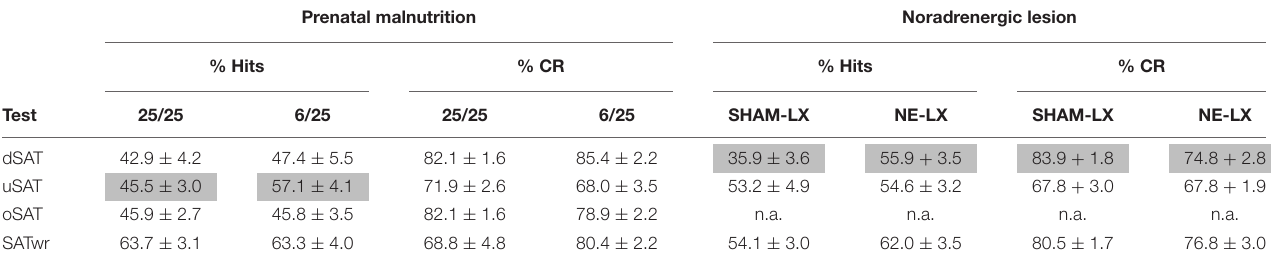
TABLE 2 | A summary of the main effects of prenatal protein malnutrition and noradrenergic lesions on the primary dependent measures from the SAT.